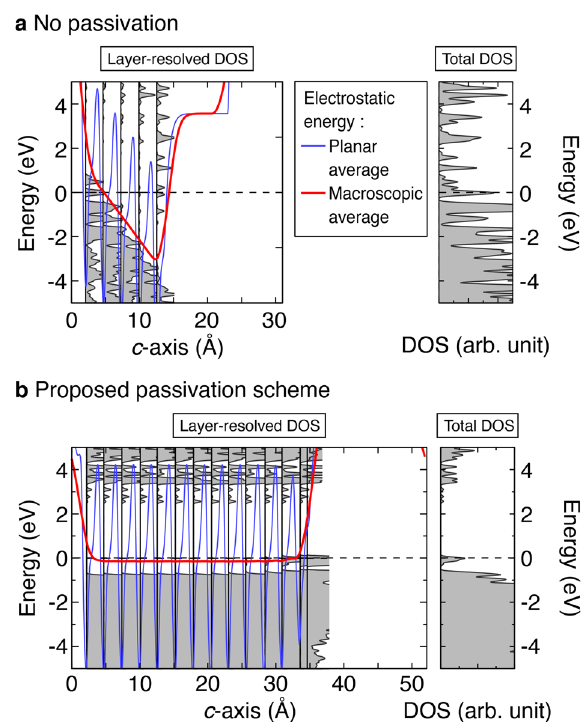
Fig. 4 Electrostatic potential energy pro fi le and LDOS. a WZ ZnO (0001) (1 × 1) fi ve BL slab to which no passivation is applied and breakdown has occurred, i.e., the charge has been transferred from one side of the slab to the other. b WZ ZnO(0001) (2 × 2)-O ad 13 BL slab for which the O dbs on the left surface has been passivated using the proposed passivation scheme. The planar-averaged and the macroscopic electrostatic potential energies are shown as blue and red solid lines, respectively. The LDOS along the z -axis (axis perpendicular to the slab surfaces) is resolved for each Zn – O BL and shown in gray. The energy of the highest occupied state is set to 0 i.e., all cation/anion dbs states are completely empty/ fi lled. However, the slab surfaces are no longer charge-neutral. The macroscopic electric fi eld induced by the charge transfer results in canted valence and conduction bands (Figs. 3b and 4a).